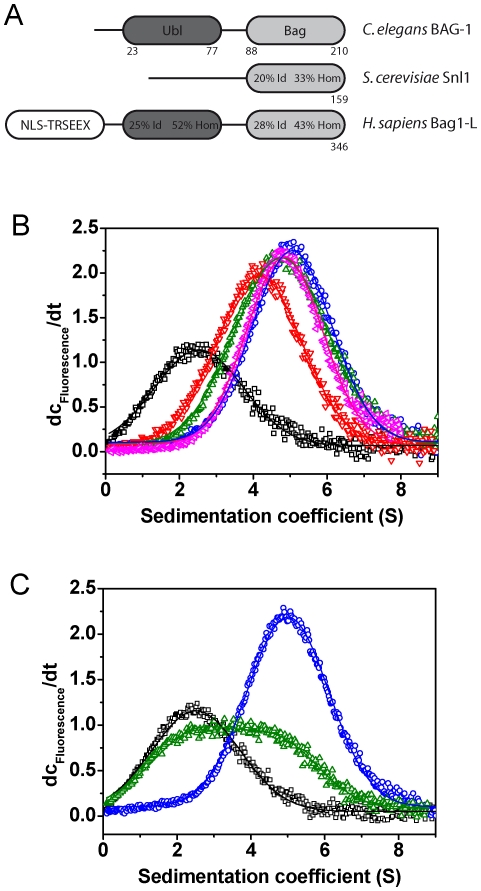
The function of the NEF BAG-1 is conserved in context with CeHsc70.(A) Domain organization of BAG-1 homologs from C. elegans, H. sapiens and S. cerevisiae. Percentages relate to identical (Id) and homolog (Hom) residues in respect to the nematode protein (Ubl: ubiquitin-like domain, Bag: BAG-domain, NLS: nuclear localization signal, TRSEEX: region containing multiple repetitions of the pentapeptide TRSEEX. (B) dc/dt plots were generated from sedimentation velocity experiments of 300 nM *BAG-1 in the absence (black) or presence of 3 µM CeHsc70 (blue) or 3 µM of the isolated ATPase domain CeHsc70-Δ384 (red), the full lid-deletion CeHsc70-Δ512 (green) and the half-lid deletion construct CeHsc70-Δ545 (pink). (C) dc/dt plots were generated from sedimentation velocity experiments of 300 nM *BAG-1 alone (black) or in the presence of 3 µM CeHsc70 (blue). The influence of nucleotides was analyzed by addition of 4 mM ATP (green) to 300 nM *BAG-1 and 3 µM CeHsc70. Data were analyzed as described in the Materials and Methods section.